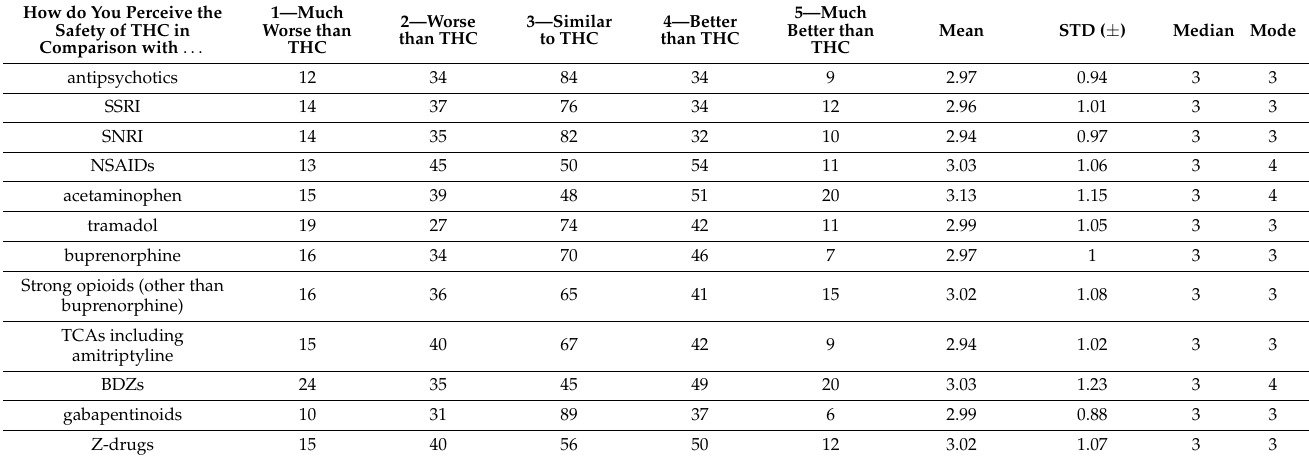
Table 4. Safety of cannabinoids in comparison with other classes of